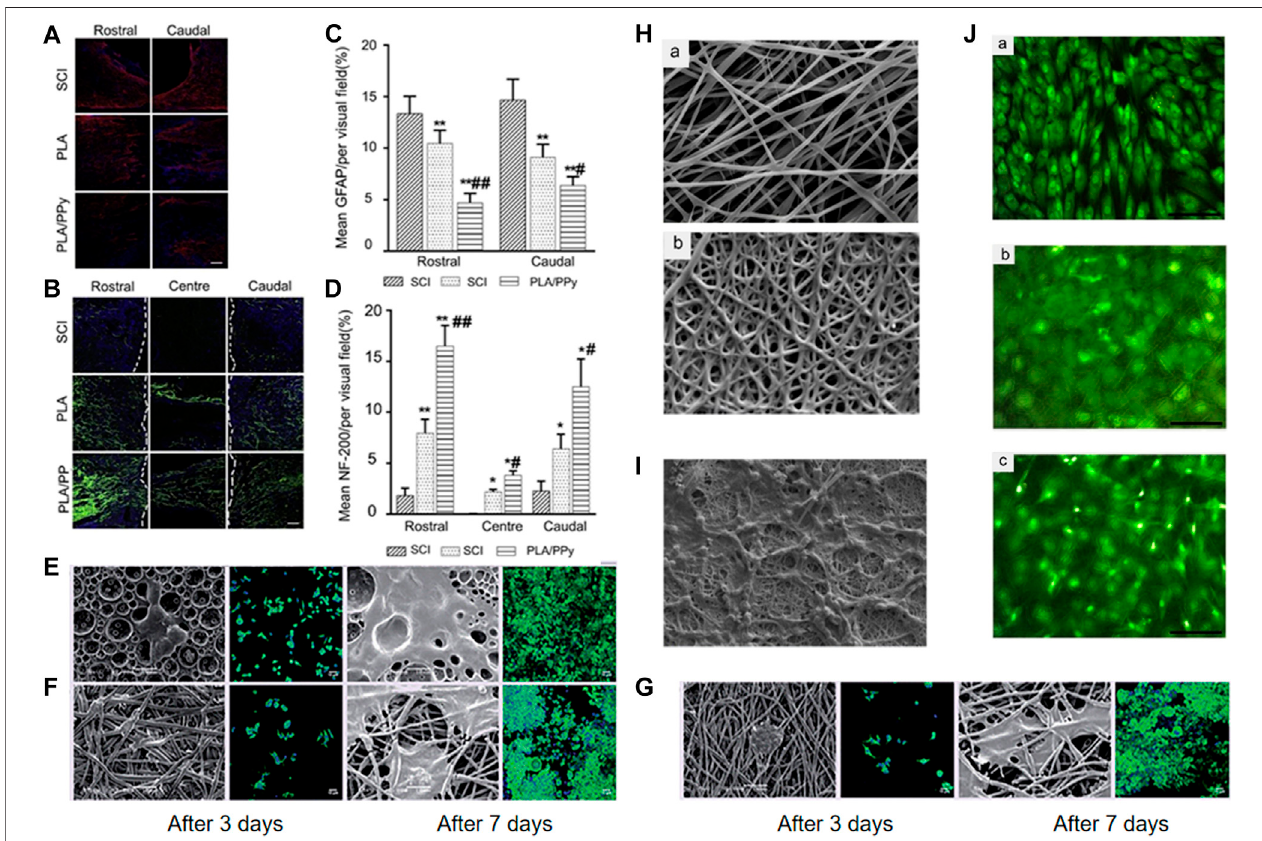
FIGURE4| Astrocyteactivationdecreasedandaxonalregenerationincreasedafter6 weeksofinjury.Immunostainingimagesofsurroundingtissuesstainedby (A) antiglial fi brillary acidic protein (GFAP) (red) and (B) NF200 (green) antibody in different groups 6 weeks after injury. Quantitative analysis of axons stained by (C) GFAP and (D) NF200-positiveindifferentgroups.* p < 0.05,** p < 0.01.* p < 0.05versusSCIgroup,** p < 0.01versusSCIgroup.# p < 0.05versusPLAgroup, ## p < 0.01versus PLA group. Scale bar (cid:1) 100 μ m. Reproduced with permission (Shu et al., 2019). 2019, Elsevier. Scanning electron microscopy and fl uorescence microscopy micrographs of PC12 cells cultivated on different scaffolds after culture for 3 and 7 days: (E) PLGA fi lm; (F) PLGA scaffold; (G) PLGA/FGF-2 scaffold. Reproduced with permission(Reisetal.,2018).2018,FutureScience. (H) SEMmicrographsofelectrospun(a)PCLand(b)PCL/gelatinscaffolds. (I) .SEMmicrographsofthemorphology of hiPSCs loaded on PCL/gelatin scaffolds after 14 days. (J) Fluorescence microscopy micrographs of cells stained by acridine orange and grown in (a) control sample, (b) PCL nano fi bers, and (c) PCL/PEG nano fi ber scaffolds for 3 days. Reproduced with permission (KarbalaeiMahdi et al., 2017). 2017, Elsevier.